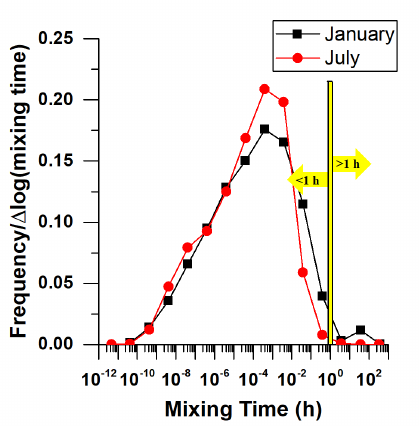
Figure 4. Normalized frequency distributions of mixing times within α -pinene SOA in the planetary boundary layer (PBL). Black symbols correspond to January and red symbols corresponds to July. Frequency counts in the PBL were only included for the con- ditions where the mass concentration of total organic aerosol was > 0 . 5µgm − 3 at the surface. The viscosity parameterization used to calculate mixing times was based on α -pinene SOA generated using mass concentrations of ∼ 1000µgm − 3